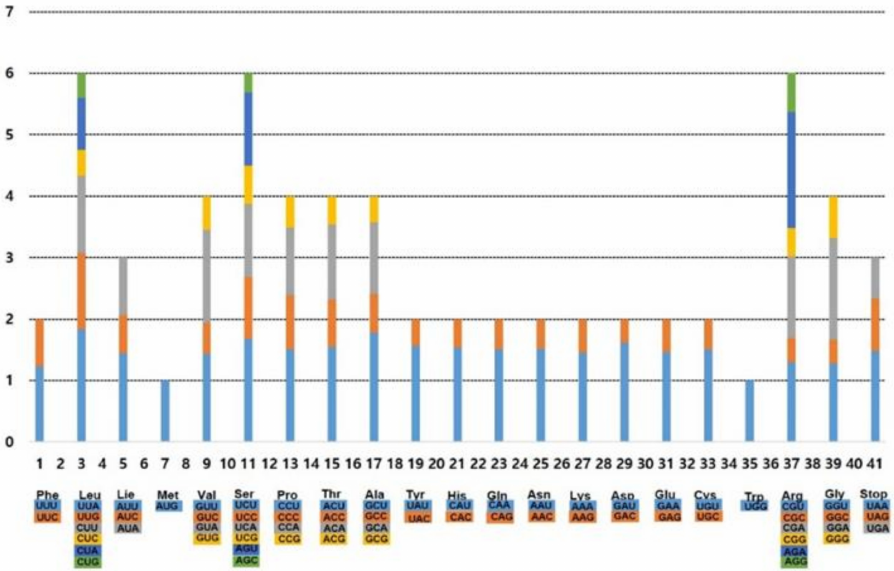
Figure 2. Codon distribution and relative synonymous codon usage in the 12 plastomes of Hosta . The predicted number of RNA editing sites in 12 Hosta plastomes representing three subgenera was 67, with the same cut-off value of 0.8, and 24 of 35 protein-coding genes were predicted to undergo RNA editing (Supplementary Table S2). These genes included 12 photosynthesis-related genes ( atpA, atpF, ccsA, ndhA, ndhB, ndhD, ndhF, ndhG, petB, petD, psaB, and psbF ), eight self-replication genes ( rpl2, rpl20, rpoA, rpoB, rpoC1, rpoC2, rps8, and rps14 ), and four other genes ( accD, clpP, matK , and ycf3 ). We detected no RNA editing sites in 11 genes (i.e., atpB, atpI, petG, petL, psaI, psbB, psbE, psbL, rpl23, rps2 , and rps16 ), which was identical in all 11 Hosta plastomes. Of the 12 Hosta plastomes included in this study, RNA editing sites in petD (four sites; all from leucine to phenylalanine) and psaB (one site; from threonine and methionine) were found uniquely in H. capitata (Iya Valley accession, Japan) and H. plantaginea , respectively. The ndhB gene showed the highest number of potential editing sites (15 sites), followed by rpoB (six sites), ndhF (five sites), and ndhD (four sites). Hosta clausa contained only two RNA editing sites in ndhD , while the other Hosta species had four RNA editing sites. In the case of H. minor , four RNA editing sites in the clpP gene were found, while the other Hosta species had only one site. Based on the K2P model, we calculated the pairwise sequence distances among six accessions of H. capitata (subg. Bryocles , sect. Stoloniferae ) distributed disjunctly in Korea and Japan (Supplementary Table S3). The distance between the two accessions of H. capitata from Korea was 0.00003, while it was 0.00012 on average ( ± 0.00000256, standard deviation, SD) for four accessions from Japan. The average pairwise distance between accessions in Korea and Japan was 0.000198 ± 0.00002659. In terms of the K2P distance for a sister species identified in this study, we found 0.00026 between H. jonesii and H. tsushimensis (subg. Bryocles , sect. Lamellatae ) and 0.00008 between H. ventricosa (subg. Bryocles , sect. Bryocles ) and H. sieboldiana (subg. Giboshi ). The distance between the two Korean endemics, H. minor and H. venusta , was 0.00003 ±